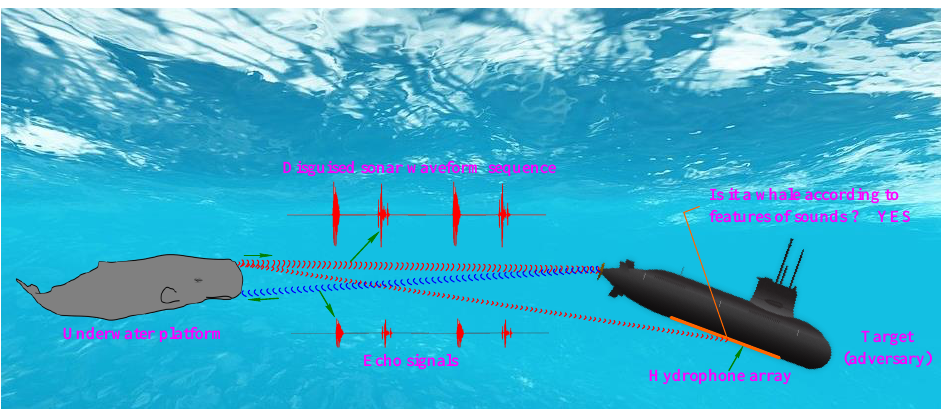
Figure 1. Bio-inspired covert active sonar strategy.